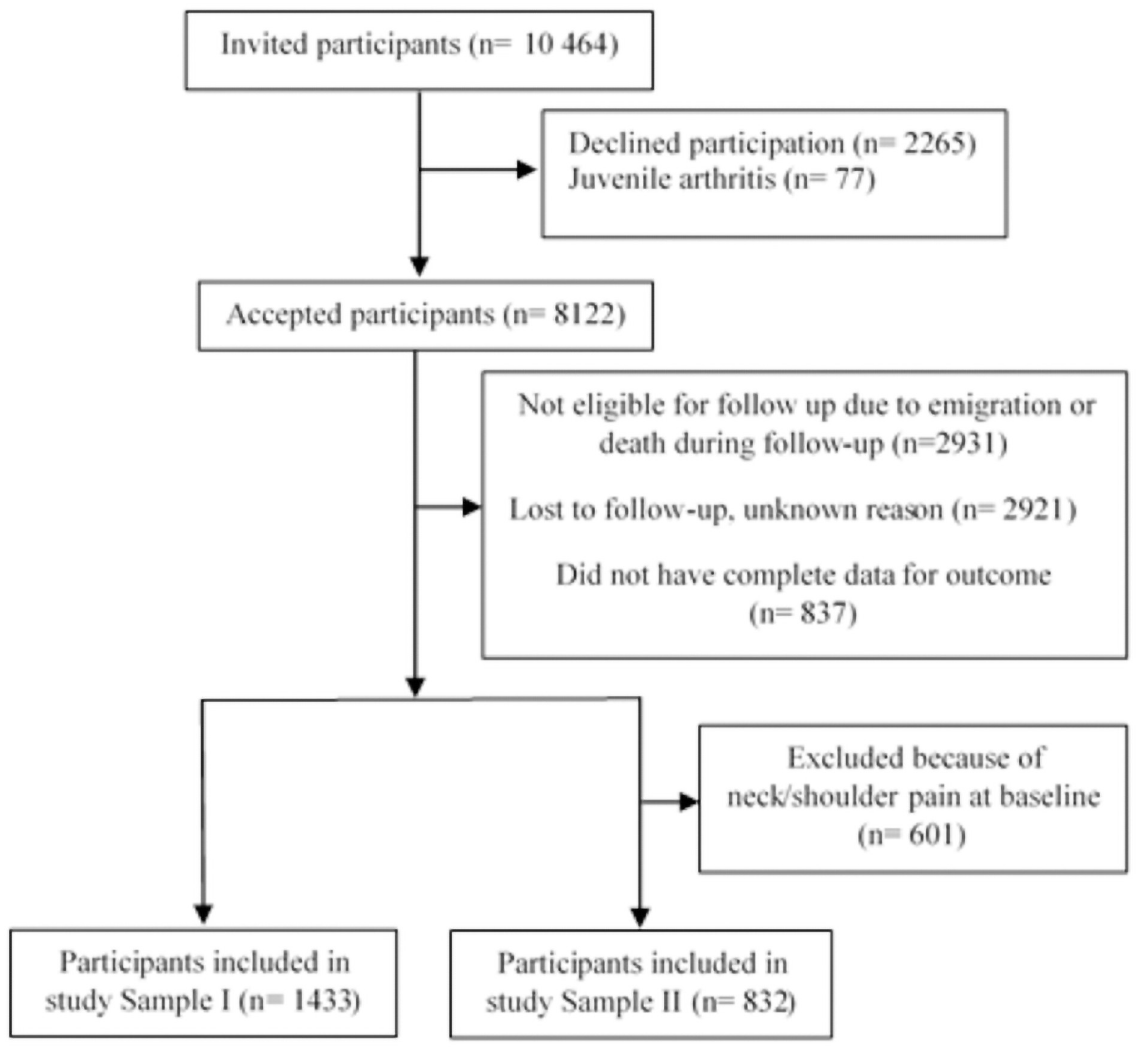
Fig 1. Flow-chart of study